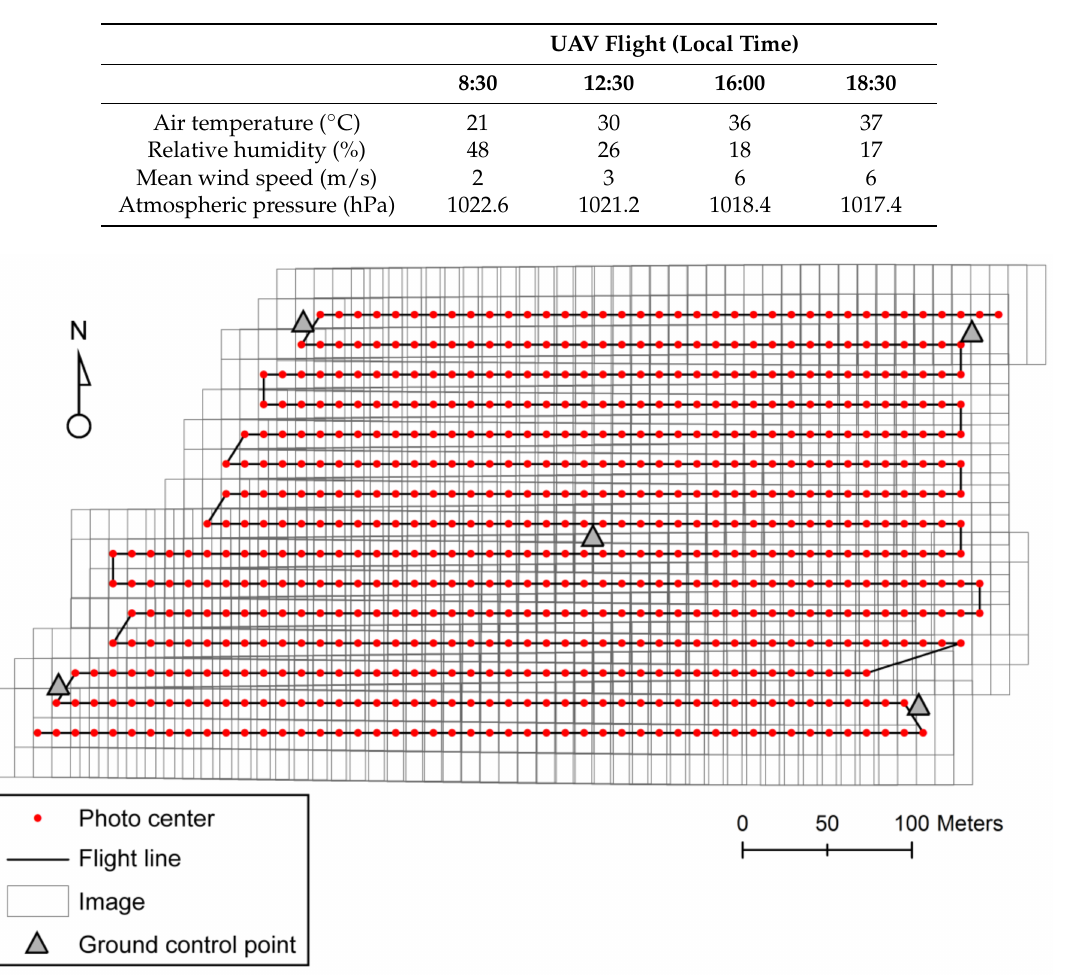
Table 1. Atmospheric conditions for individual unmanned aerial vehicle (UAV) flights on 1 June 2016.